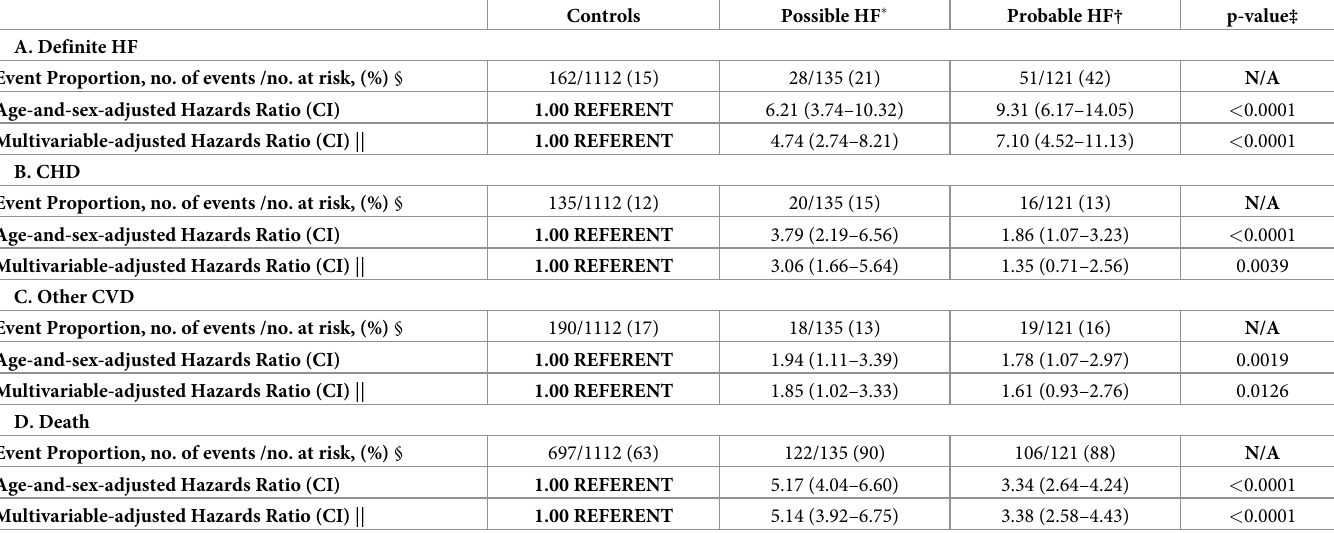
Table 3. Risk of various clinical events in those with possible and probable HF compared with